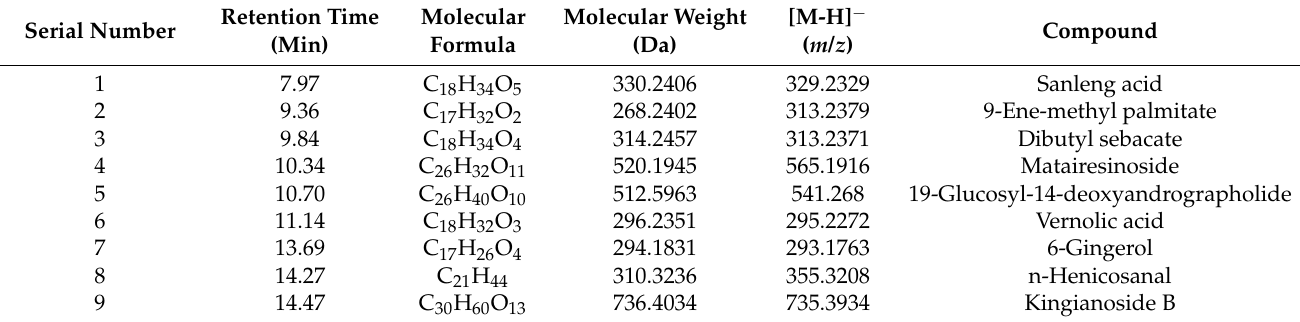
Table 1. Mass spectrometric data (retention time, molecular formula, molecular weight, and charge-to-mass ratio) of the verified